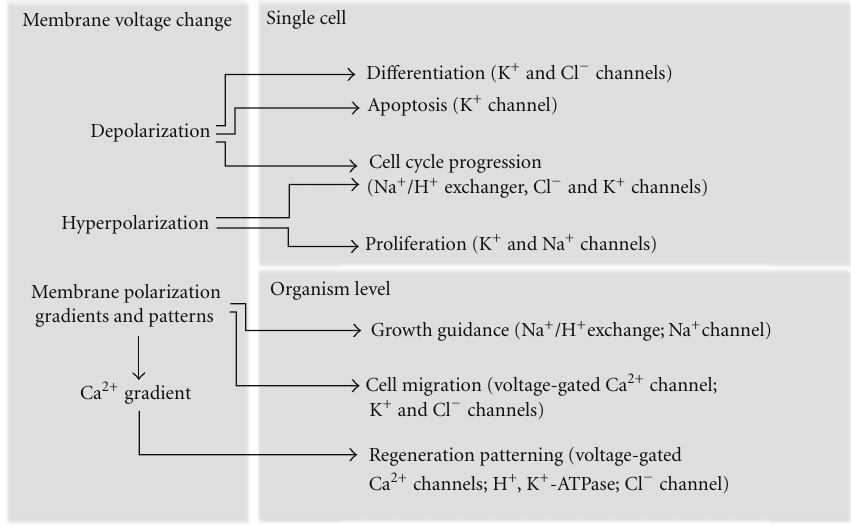
Figure 1: Ion channels and membrane voltage during regeneration. Changes of membrane potentials can directly a ff ect di ff erent aspects of cell behavior and large-scale morphogenetic processes during regeneration. Ion channels and transporters implicated in these processes are mentioned in